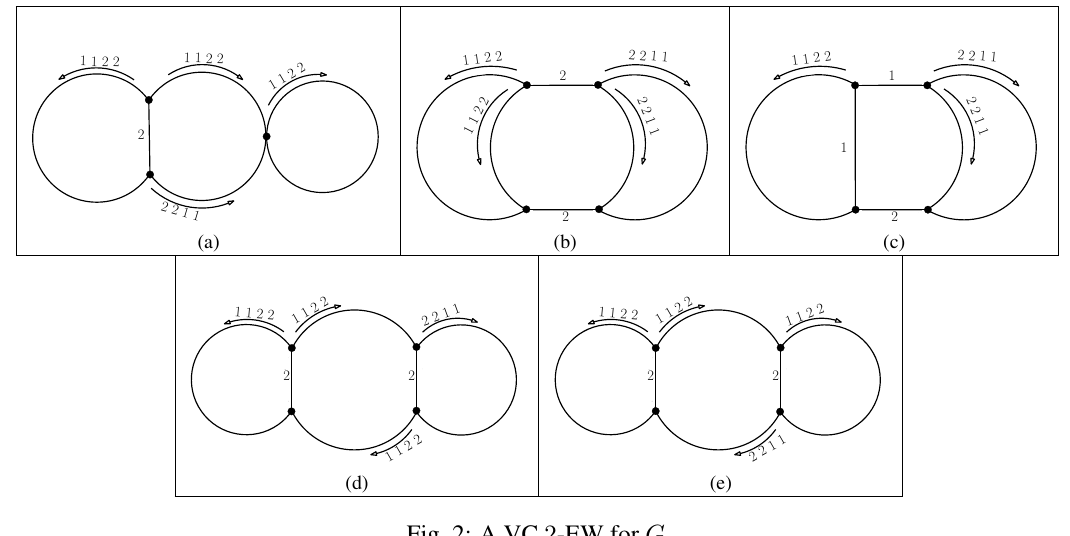
Fig. 2: A VC 2 -EW for G